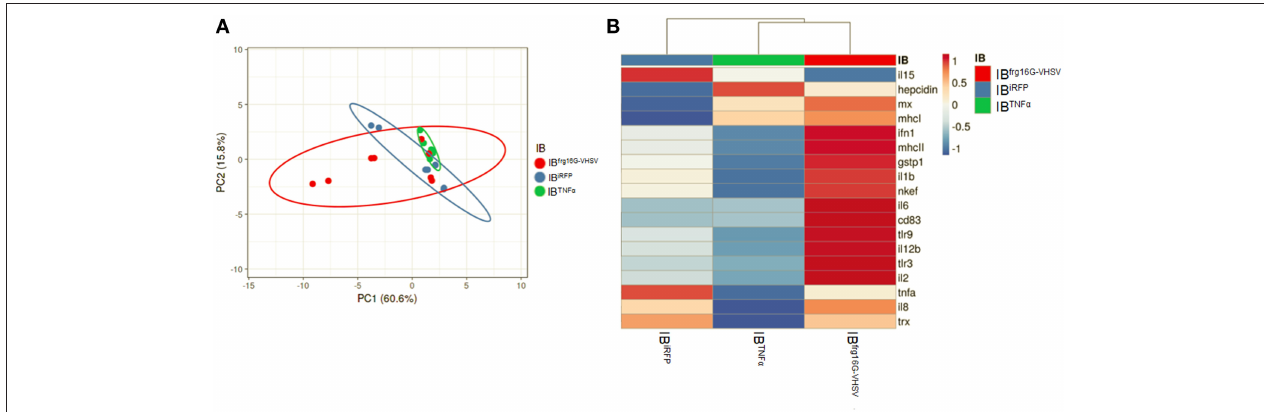
FIGURE 6 | Principal component analysis (PCA) of immune-gene expression evaluation of RBCs from rainbow trout injected intravenously with IB iRFP , IB TNF α , or IB frg16G − VHSV , at 48h post-injection. (A) PCA plot of molecular (gene expression data, 2 − 1 Ct ) signatures of IB iRFP , IB TNF α , or IB frg16G − VHSV treated samples, at 48h post-injection. Ellipses and shapes show clustering of the samples. (B) Heatmap of molecular (gene expression data, 2 − 1 Ct ) signatures of IB iRFP , IB TNF α , or IB frg16G − VHSV treated samples. Annotations on top of the heatmap show clustering of the samples mean values. PCA plot and heatmap was performed using Clustvis software. Heatmap data matrix visualizes the values in the cells using a color gradient which gives an overview of the largest and smallest values in the matrix.